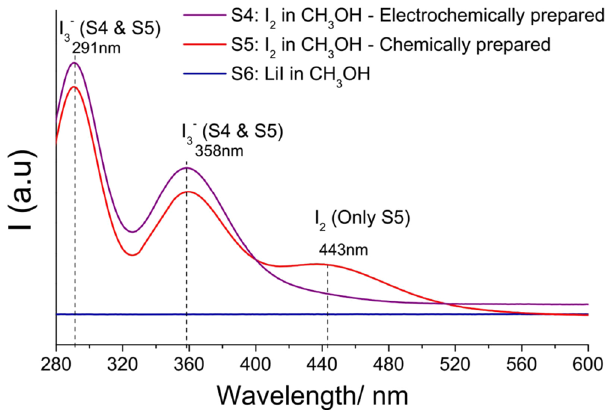
Figure 5. UV-VIS spectra of catholyte solutions before and after charging. S4: Electrochemically prepared iodine in methanol (by charging LiI/CH 3 OH). S5: Chemically prepared iodine in methanol. S6: Lithium Iodide in